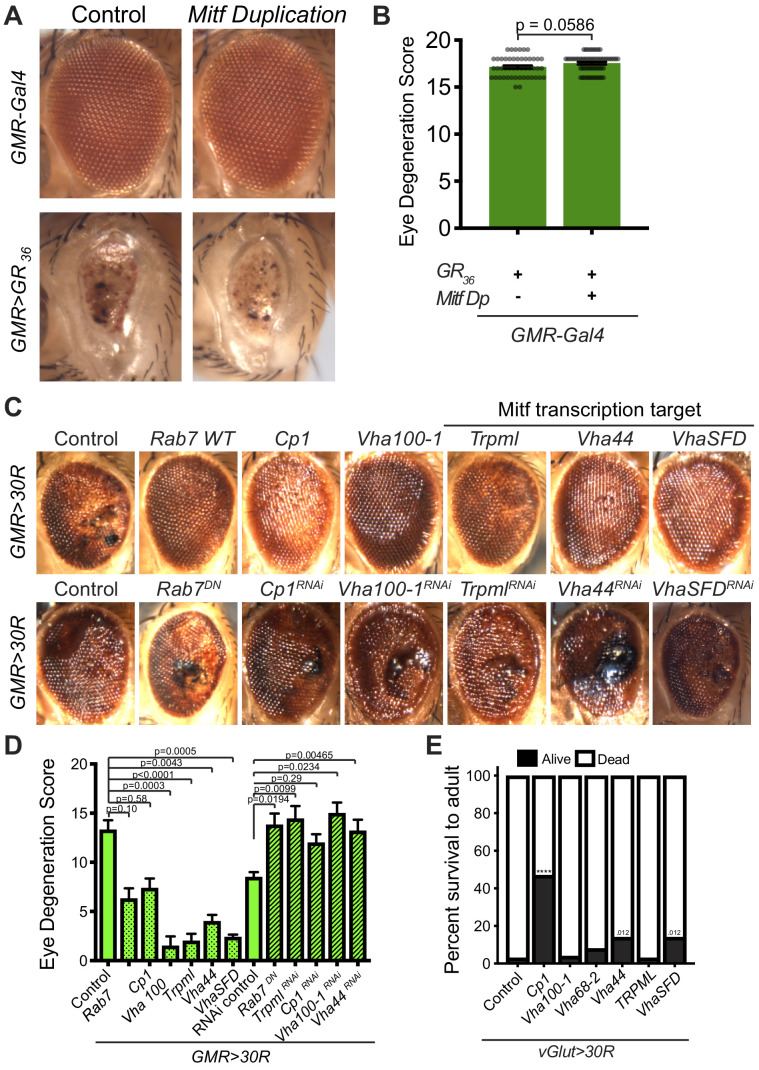
Genetic increase of lysosome function rescues degeneration caused by G4C2 expression but not by poly-GR.(A) 15-day-old Drosophila eyes expressing poly-GR36 under the control of the GMR-Gal4 with control (w1118) or Mitf Dp. (B) Quantification of external eye degeneration in A. Data are presented as mean ± SEM. Mann-Whitney test, n = 48 and 59 adult flies. (C) 15-day-old Drosophila eyes expressing UAS-30R under the control of the GMR-Gal4 driver accompanying overexpression (top) or knockdown (bottom) of lysosomal genes. (D) Quantification of external eye degeneration in A. Data are presented as mean ± SEM. Kruskal-Wallis test, p<0.0001 (left) and p=0.0202 (right) followed by Dunn’s multiple comparisons, n = 10, 10, 10, 10, 8, 4, 5, 8, 6, 10, 9, 10, 4, and 10 adult flies, respectively. (E) Percent of pupal eclosion in Drosophila expressing UAS-30R under the control of the motor neuron vGlut-Gal4 driver with UAS-lacZ (control) or overexpression of lysosomal genes. Fisher’s exact test, n = 89, 120, 88, 146, 119, 123, and 105 pupa.